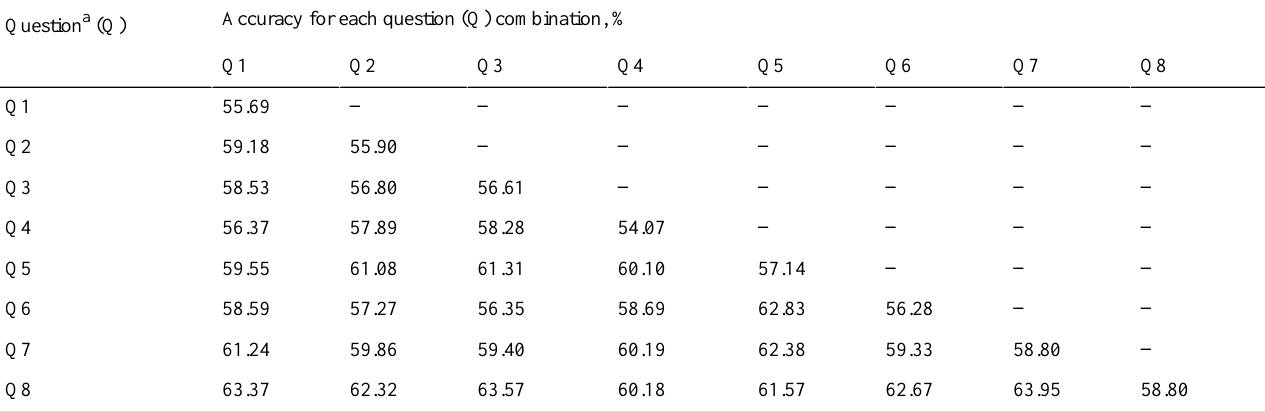
Table 5. Prediction accuracies of the support vector machine (SVM) based on the eight dynamic ecological momentary assessment (EMA-D) questions and their combinations.